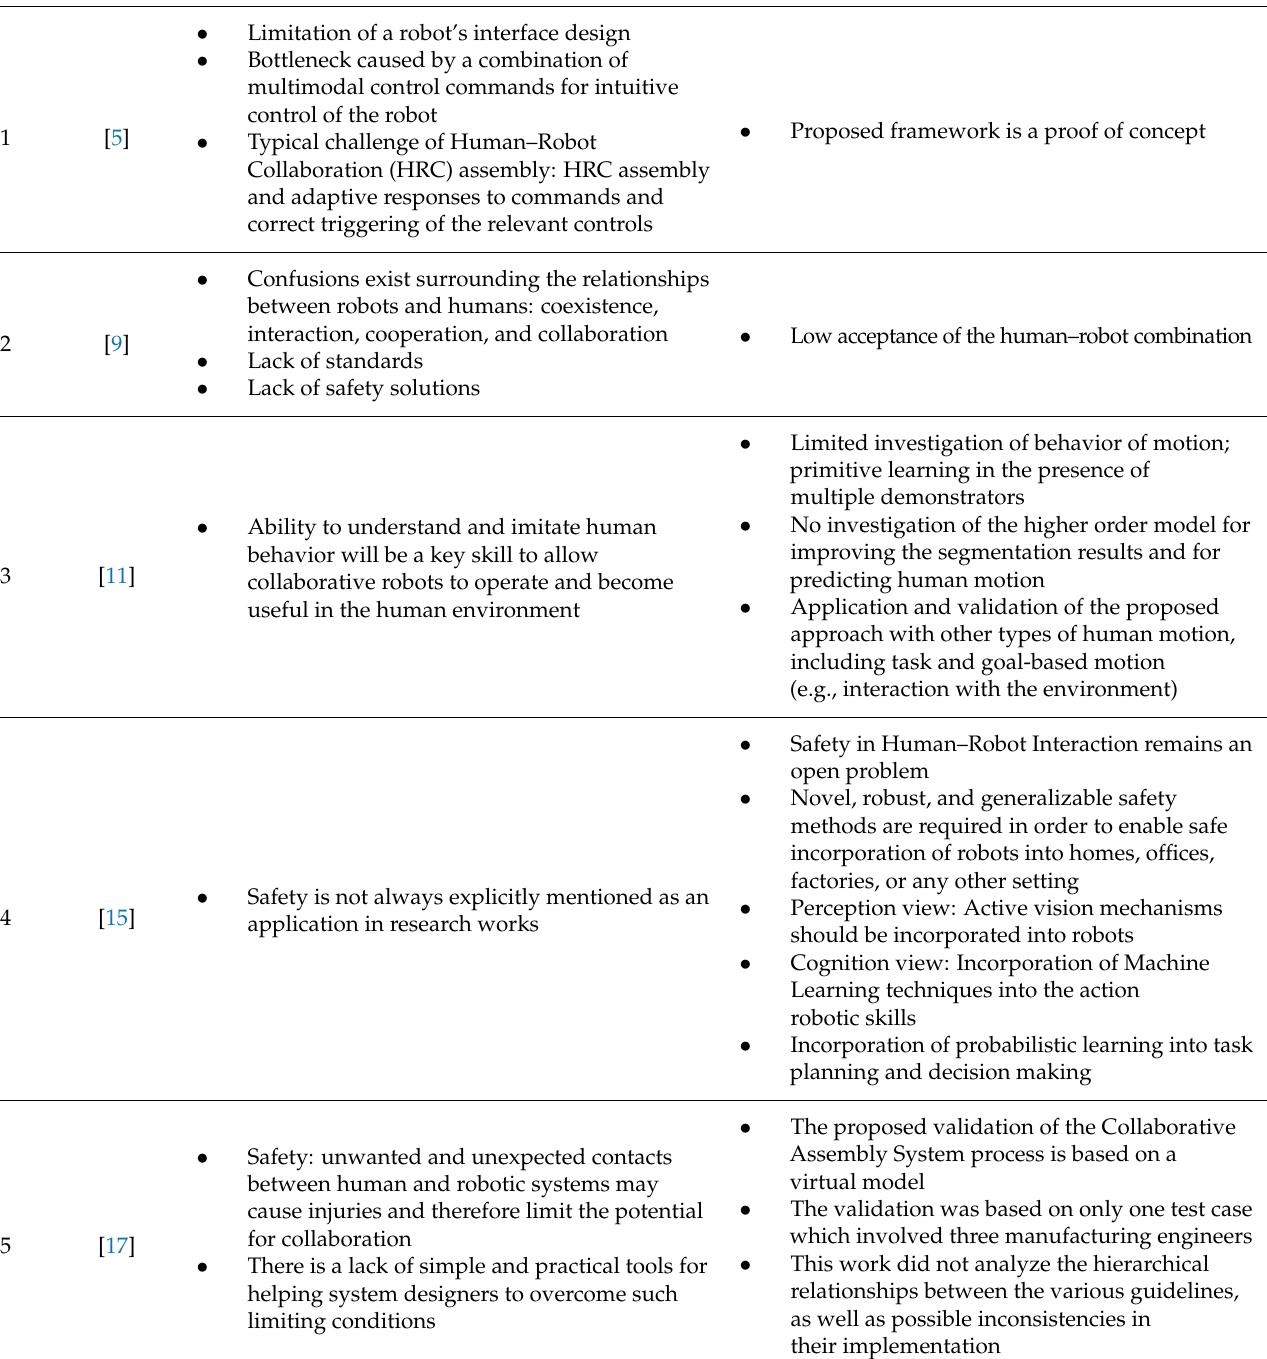
Table 1. Identified limitations and challenges in the field of HRC. A/A